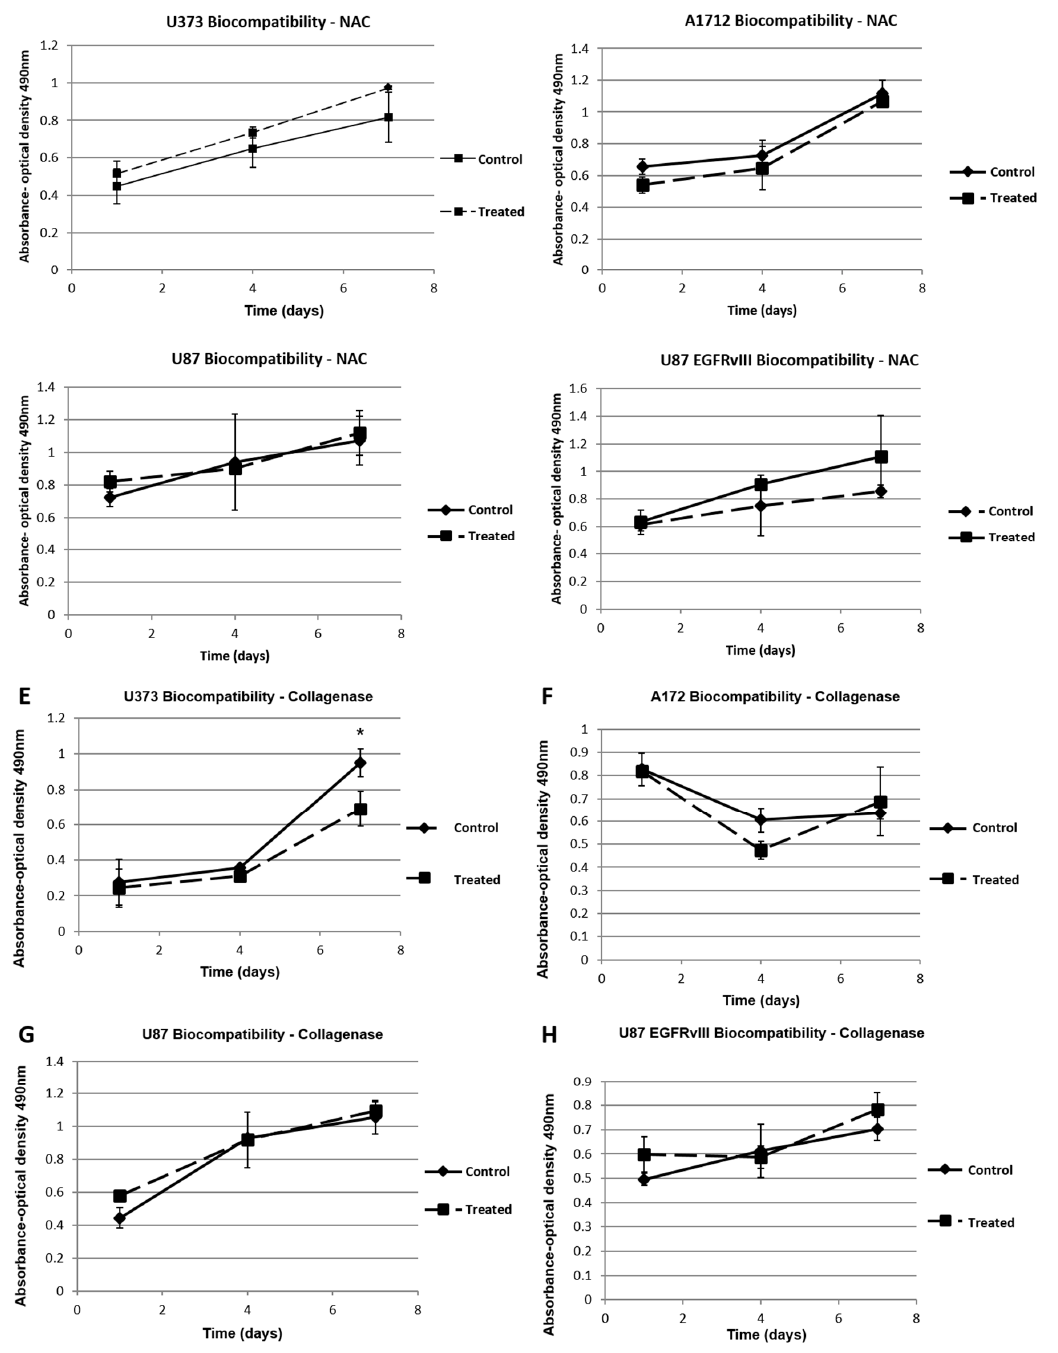
Figure 7. Biocompatibility assays of cells with N -Acetyl- L -cysteine ( A ) U373 cells; ( B ) A172 cells; ( C ) U87 cells and ( D ) U87 EGFRvIII cells. Biocompatibility assays of cells with collagenase/hyaluronidase; ( E ) U373 cells; ( F ) A172 cells; ( G ) U87 cells and ( H ) U87 EGFRvIII cells. Other than the case of U373